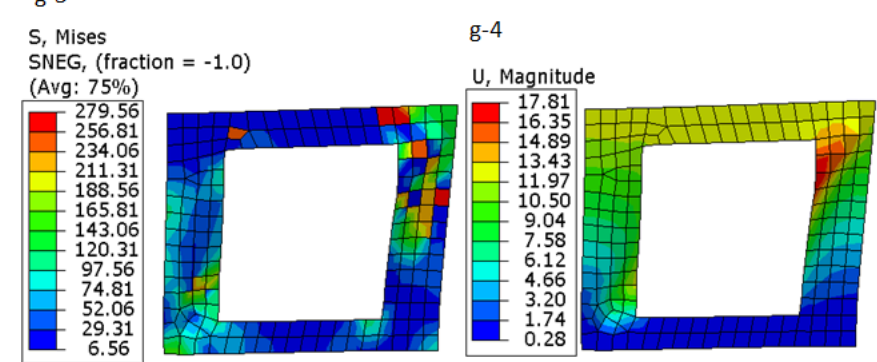
Figure 22. Figure 18 Von Mises stress for shell part (g-1) frame part and (g-2) steel plate.